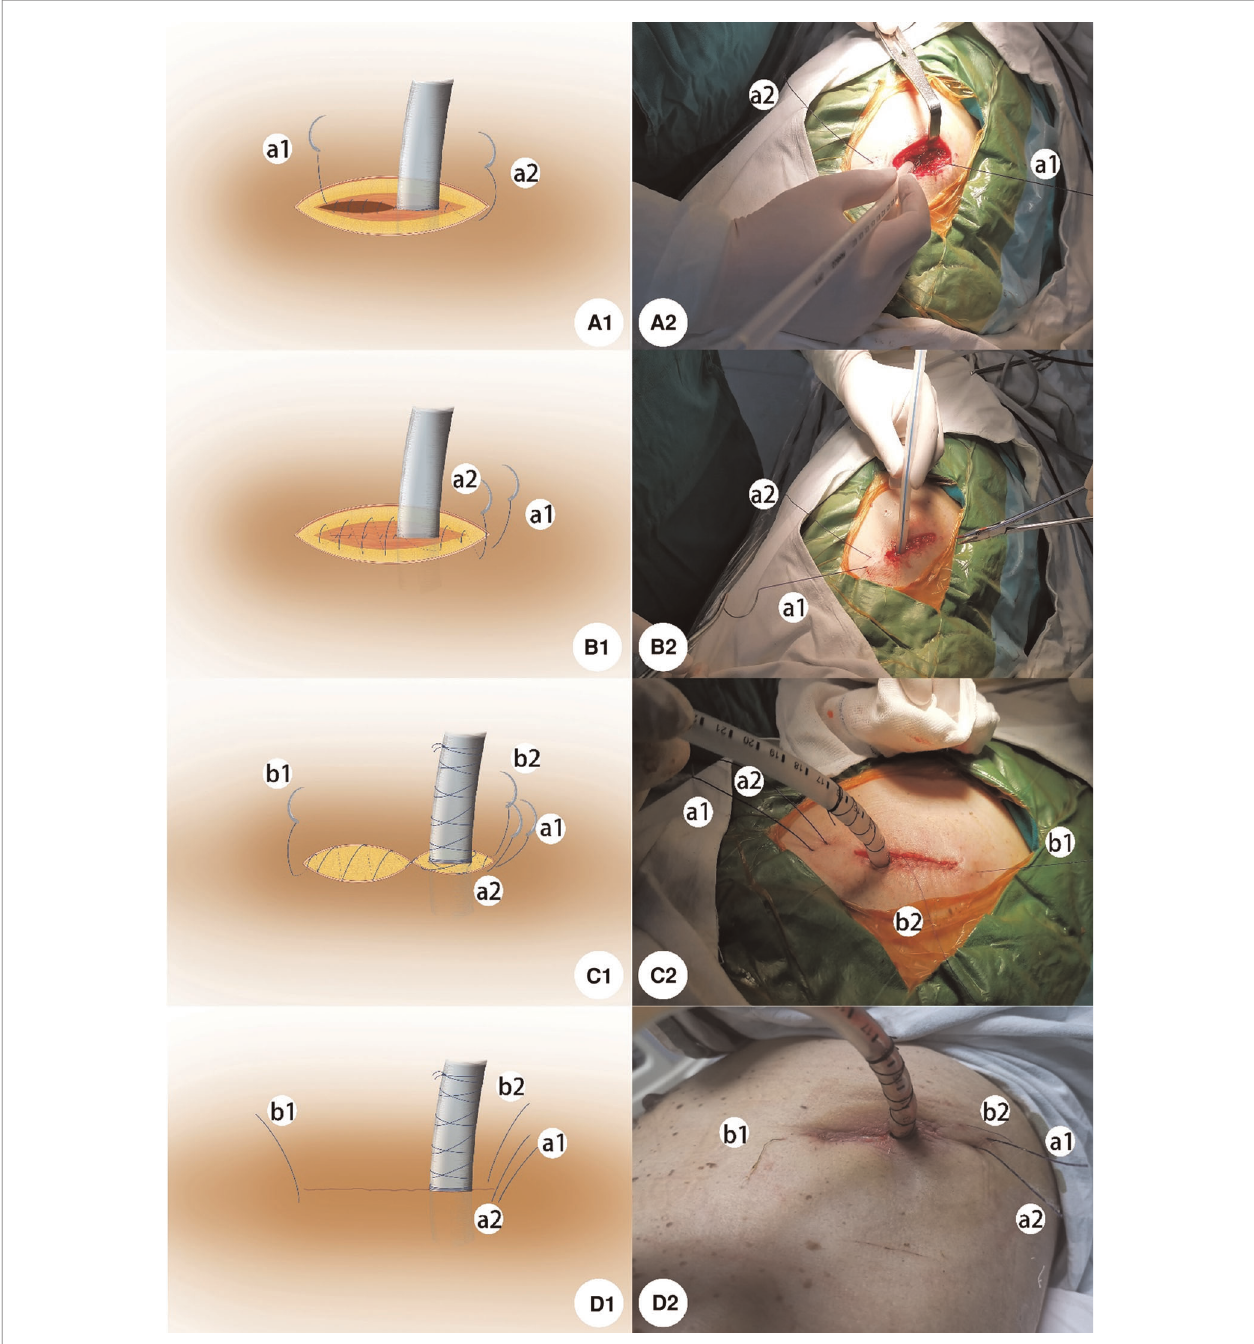
FIGURE 1 | ( A1 ) Suture of the muscle layer started in the middle of the incision and some knots were tied to lock up the suture. Then, the muscle was sutured continuously from the middle of the incision to each side. ( B1 ) On the tube side, the side of a2 of the suture passed under the skin and came out through the skin about 1.5 cm from the edge of the incision when the needle reached the end of the incision. On the side of a1, after the suture of muscle fi nished, the suture of subcutaneous tissue started with a continuous suture technique by the same needle from this side to the chest tube side, and the stitch came out through the skin same as before. ( C1 ) For anchoring the chest tube, a horizontal mattress suture was used to suture the dermis and some subcutaneous tissue followed by a knot in a side of the incision to tighten up the tissue around the tube. Then using the thread twined around the tube with tension in opposite directions orderly. Several rounds in the beginning enlaced at the root of the tube for stabilization, and the following rounds climbed around the tube wall up to 6 – 8 cm away from the tube root. For closing the dermis layer, a continuous suture was used from the middle of the incision to each side. When reaching each end of the incision, two needles came out through the skin about 1 cm away from each edge of the incision respectively. ( D1 ) Procedure fi nished as shown in the picture. A-D2 shows the actual operation pictures corresponding to the schematic diagram of A-D1.